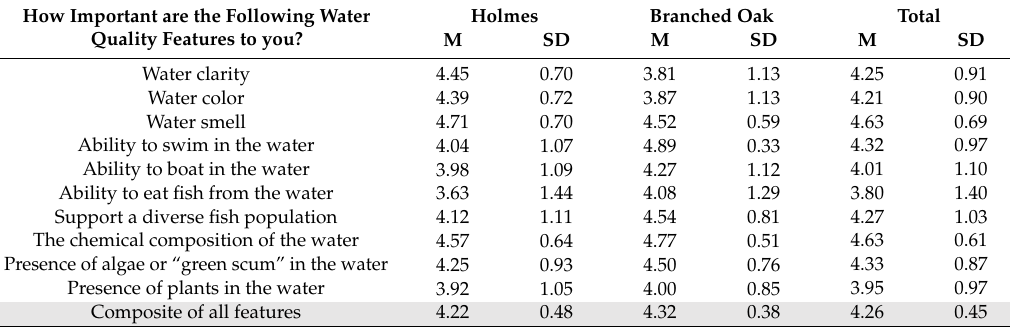
Table 6. Importance of water quality features means (M) and standard deviations